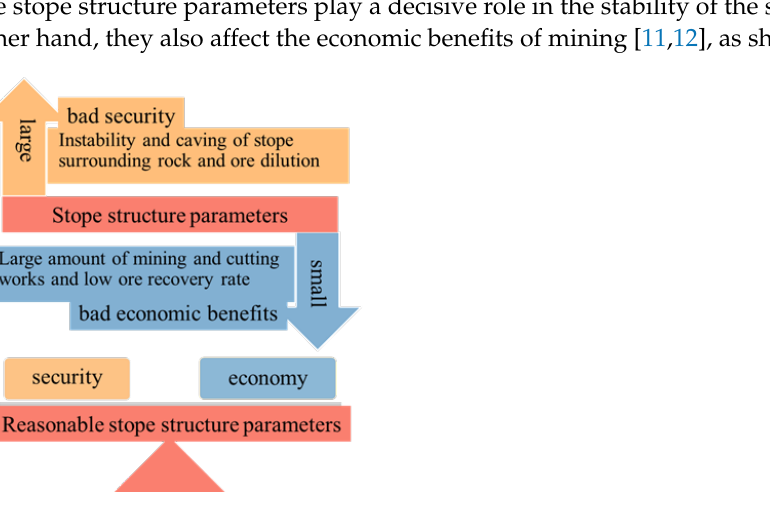
Figure 3. Design process of stope structural parameters. 2.3. Critical Span Graph The rock mass rating (RMR) critical span graph has been compiled by experts and scholars at home and abroad based on a large amount of data measurements [13,14]. Since the RMR critical span graph was developed by Lang at the University of British Columbia in 1994 and continuously modified by experts and scholars, it has become a fast and con- venient tool for estimating the maximum span that can maintain the stability of under- ground engineering according to the RMR rock mass classification score [15]. Brady et al. updated the RMR critical span graph in 2003, as shown in Figure 4. According to the results of rock mass quality classification and based on the RMR critical span graph, the maximum span in which stability can be maintained by under- ground rock mass excavation can be determined. The RMR critical span graph is used to determine the width of the stope in the parameter design of the stope structure.